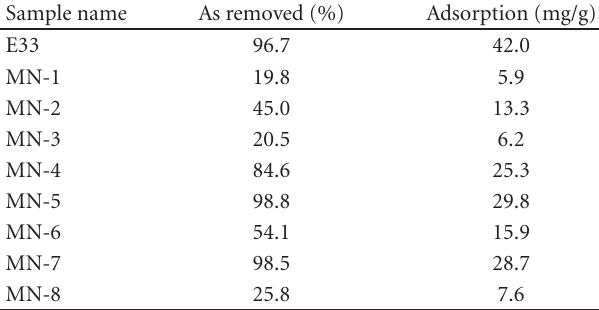
Table 2: Arsenic adsorption study